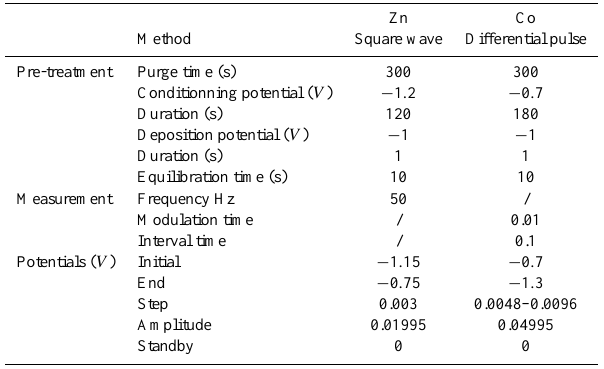
Table 1. Voltammetric procedures for Zn and Co determinations. Zn Co Method